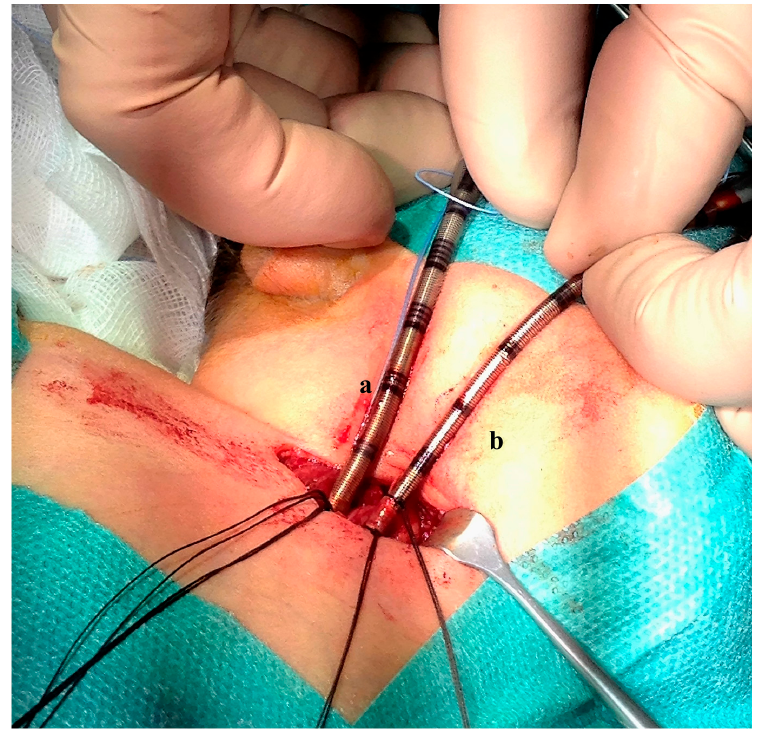
Figure 1. Peripheral extracorporeal life support. Surgical cannulation site in the neck: drainage cannula (10 French) inserted in the jugular vein ( a ), inflow cannula (8 French) inserted in the carotid artery ( b ).